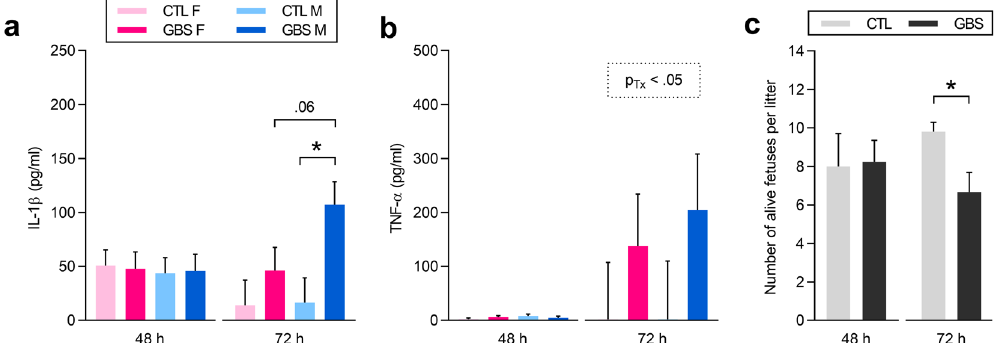
Figure 7. Sex-specific pro-inflammatory responses in the fetal circulation. ( a , b ) Mean titers of IL-1 β ( a ) and TNF- α ( b ) detected in the fetal sera at 48 and 72 h post-injection. Comparisons between GBS-exposed versus CTL fetuses by linear mixed model, with Sidak’s multiple comparisons when the interaction between sex and treatment was significant. * P < 0.05. Bars represent mean ± SEM. Significant results are shown in the dashed box. Number (n) of fetuses for IL-1 β : n = 4 [48 h] and n = 6 [72 h] per sex in the GBS group, and n = 4 [48 h] and n = 5 [72 h] per sex in the CTL group. Number (n) of fetuses for TNF- α : n = 4 [48 h] and n = 6 [72 h] per sex in the GBS group, and n = 4 [48 h] and n = 5 [72 h] per sex in the CTL group. c Mean number of alive fetuses per litter at 48 and 72 h post-injection. * P < 0.05. Bars represent mean ± SEM. Number (n) of litters: n = 4 [48 h] and n = 6 [72 h] per sex in the GBS group, and n = 5 [48 h] and n = 5 [72 h] per sex in the CTL group. Comparisons between GBS-exposed versus CTL litters by two-tailed Student’s T tests. Abbreviations: CTL, Control; F, Female; GBS, Group B Streptococcus ; h, hour; IL, Interleukin; M, Male; TNF- α , Tumor Necrosis Factor- α ; Tx,